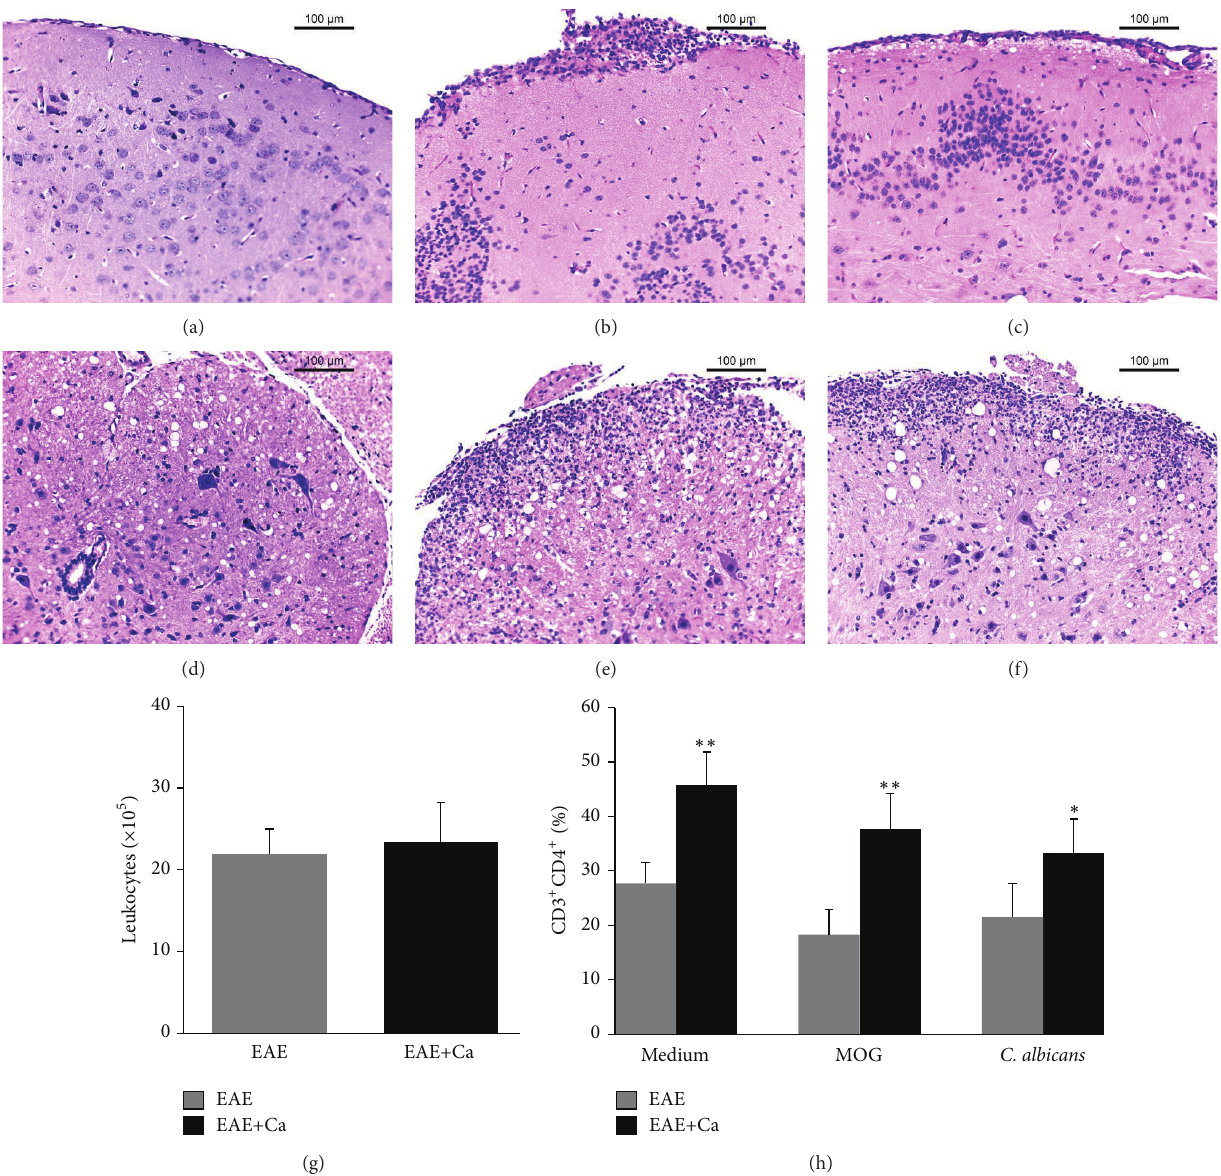
Figure 5: Previous infection with C. albicans increases the amount of CD4 + T cells in the CNS. C57BL/6 mice were infected with C. albicans and3dayslatertheyweresubmittedtoEAEinduction.FourteendaysafterEAEinduction,inflammationand%ofCD4 + Tcellswereevaluated in the CNS. Inflammatory infiltrates detected by H&E staining are shown in brain samples from EAE (b) and from EAE+Ca (c) groups and in spinal cord samples from EAE (e) and from EAE+Ca (f) groups. A brain and spinal cord samples from a normal mouse is shown in (a) and (d), respectively. Total leukocyte number (g) and percentage of CD3 + CD4 + T-cell subset (h) (analysis performed in 50.000 acquired events). The results are expressed as mean ± SD ( 𝑛 = 6 - 7 mice/group). Unpaired 𝑡 test, ∗ 𝑃 < 0.05 and ∗∗ 𝑃 < 0.01 indicate difference between EAE and EAE+Ca groups under the same in vitro